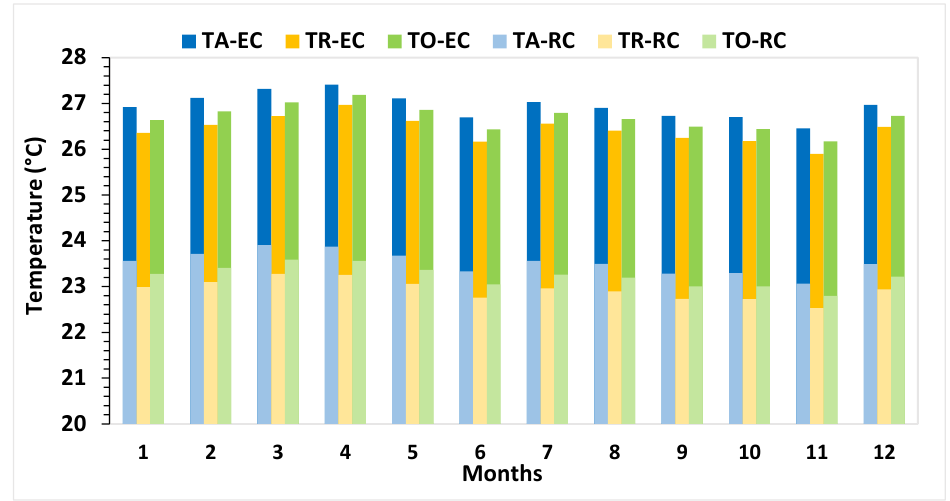
Figure 10. Monthly air temperature (AT), radiant temperature (RT), and operating temperature (OT) results for EC and RC.